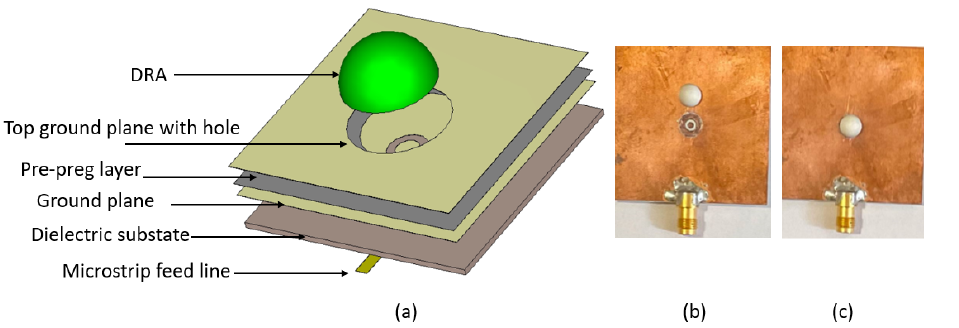
Figure 11. A hemispherical DRA with a grooved compound ground plane; ( a ) 3D layout, ( b ) Fabri- cated DRA with a grooved ground plane, ( c ) Assembled